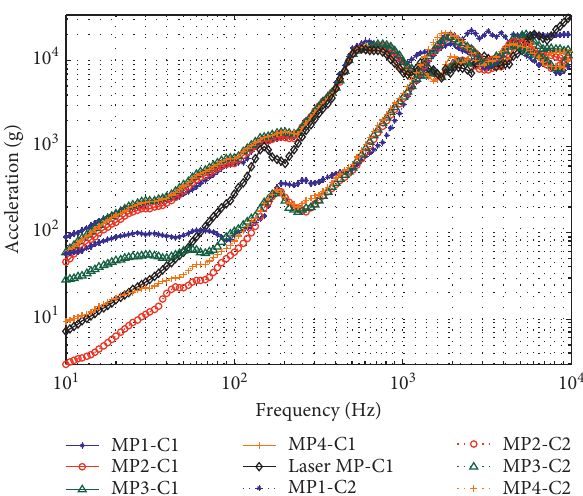
Figure 18: Acceleration shock response spectrums on C1 and C2 under higher SRS.